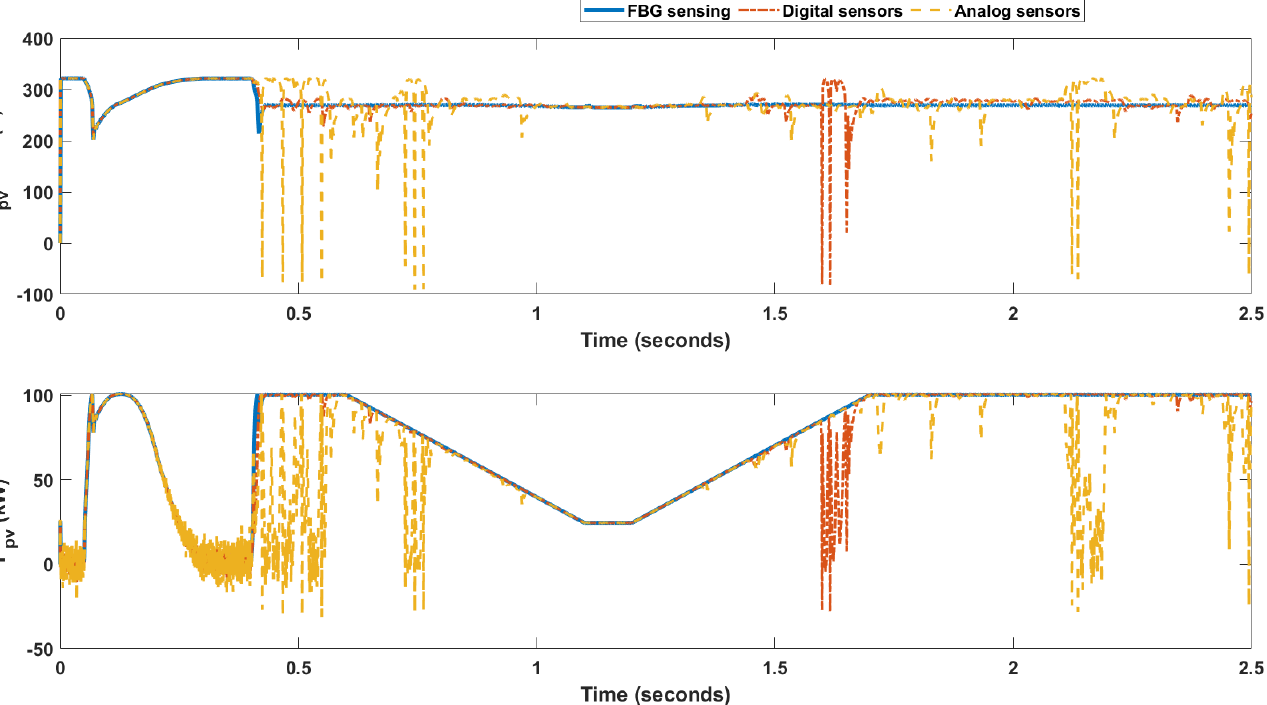
Figure 13. Output metrics at the potential point of PV array output.